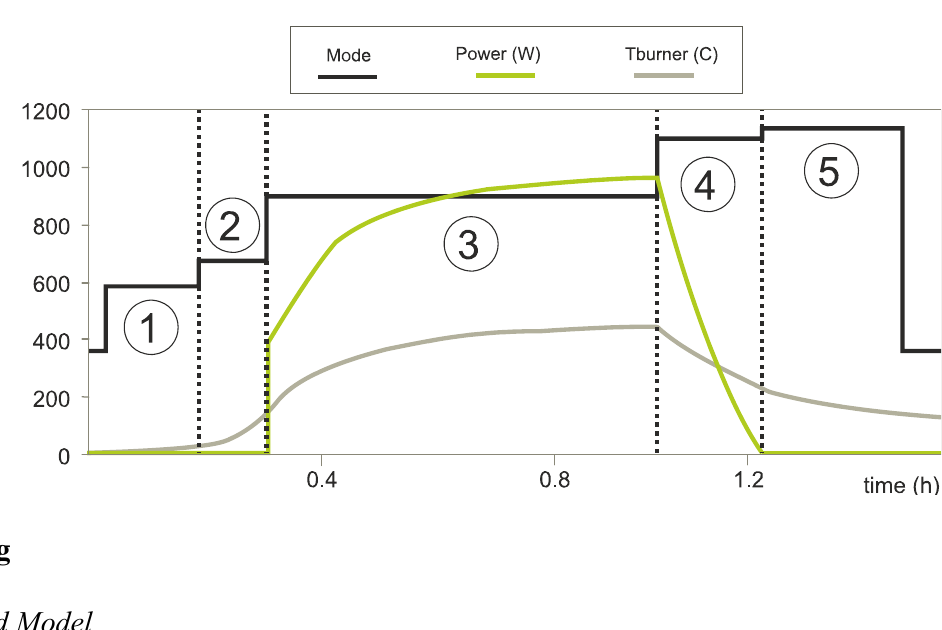
Figure 2. Operating